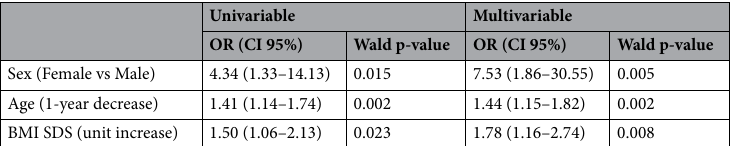
Table 2. Univariable and multivariable logistic regression model with high- vs low S-ASM. BMI body mass index, CI confidence interval, OR odds ratio, S-ASM secretory acid sphingomyelinase, SDS standard deviation